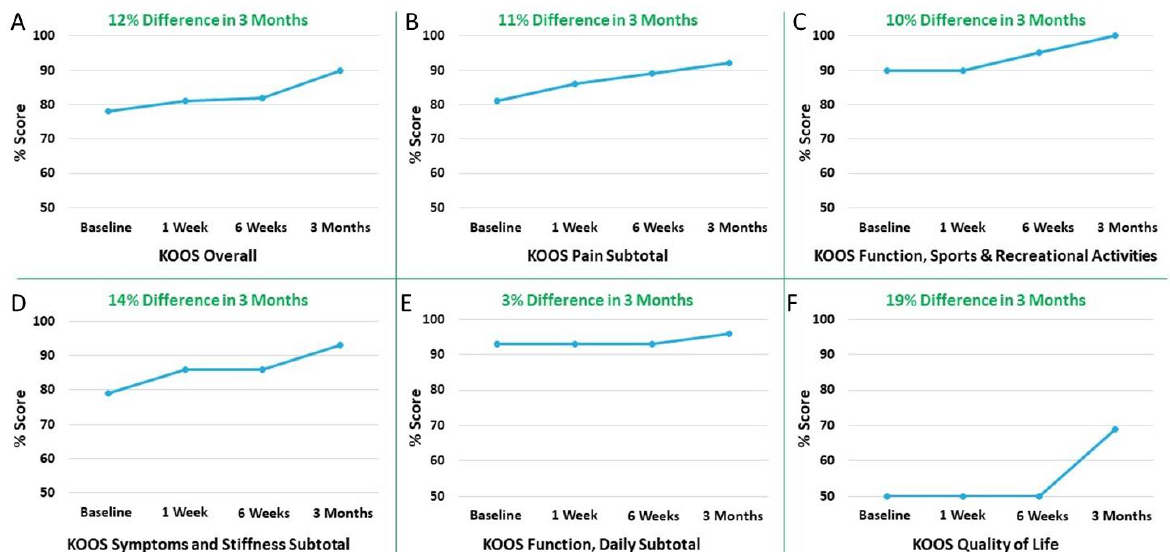
Figure 3. Knee Injury and Osteoarthritis Outcomes Score (KOOS): ( A ) KOOS Overall; ( B ) KOOS Pain Subtotal; ( C ) KOOS Function, Sports, and Recreational Activities; ( D ) KOOS Symptoms and Stiffness Subtotal; ( E ) KOOS Function, Daily Subtotal; and ( F ) KOOS Quality of Life. 12% difference (improvement) was observed over a period of 3 months compared to baseline in overall KOOS; 11%, 10%, 14%, 3%, and 19% difference (improvement) was observed over a period of 3 months compared to baseline in individual KOOS subscales including Pain Subtotal; Function, Sports, and Recreational Activities; Symptoms and Stiffness Subtotal; Function, Daily Subtotal; and Quality of Life, respectively.